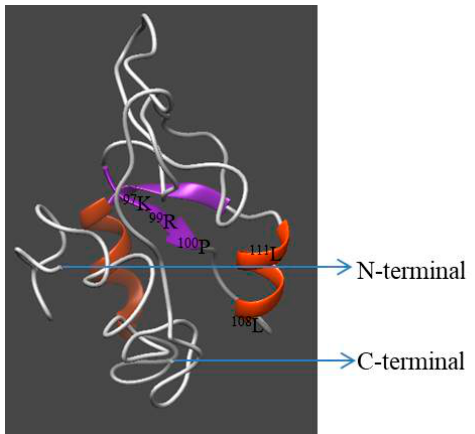
Figure 4. Predicted three-dimensional model of Hdh IGFBP-5. N- and C-termini are marked with arrows. The structure was generated using I-TASSER with a C-score of 2 to 4.